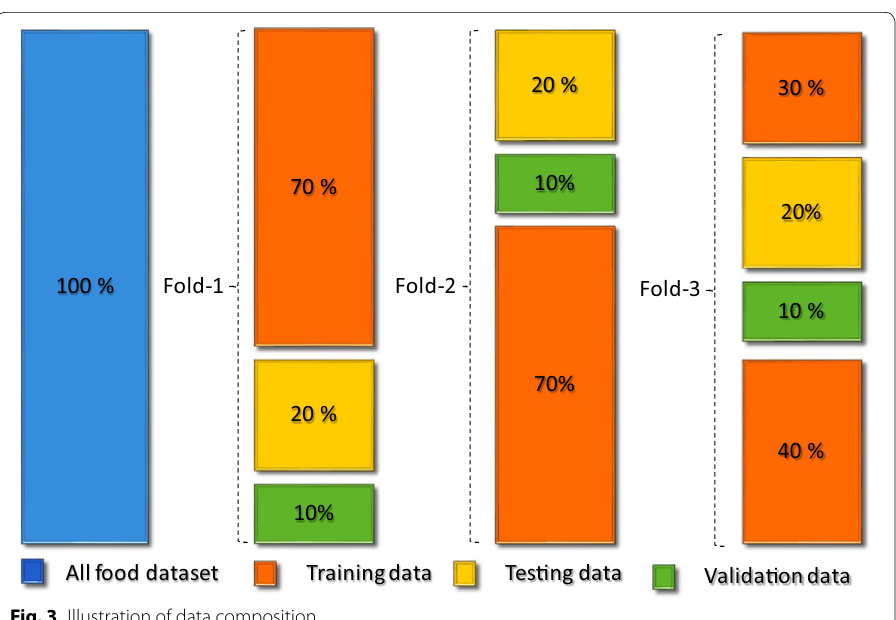
Fig. 3 Illustration of data